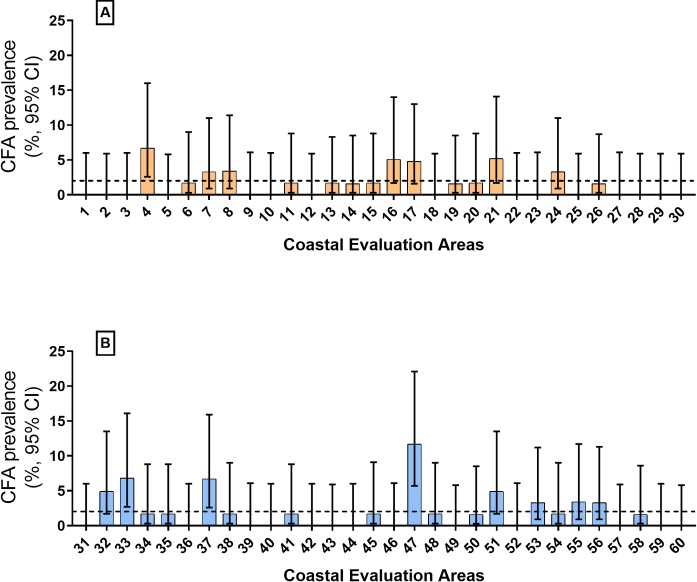
Summary of community circulating filarial antigen (CFA) prevalence in 60 evaluation areas (Public Health Midwife areas) assessed by adult-TAS in the coastal Galle evaluation unit.The antigenemia target of 2% (the upper CI for the prevalence estimate) for the EU is shown with a dotted line. The CFA prevalence was >2% in 7 of 30 evaluation areas in the first survey (panel A), and the prevalence > 2% in 8 of 30 EAs in the second survey (panel B).